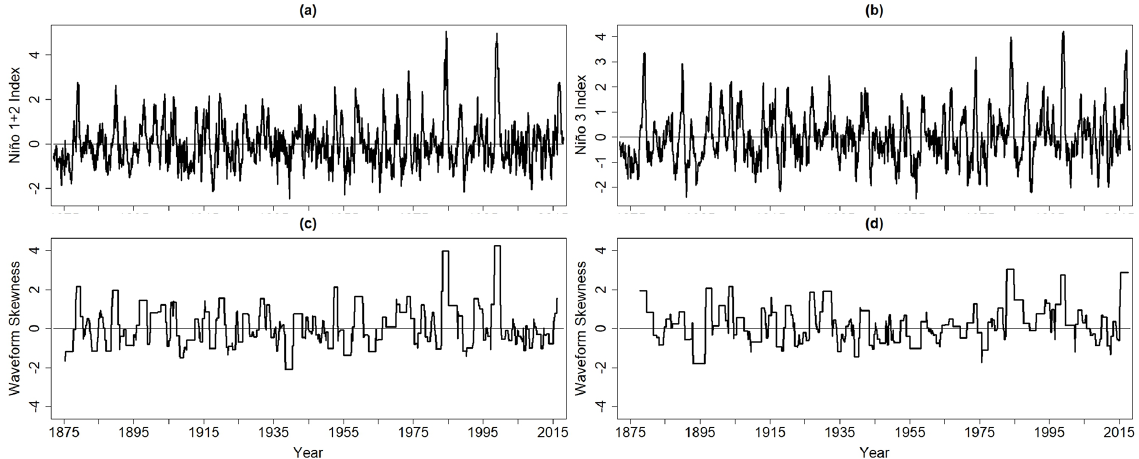
Figure 5. The standardized (a) Niño 1 + 2 and (b) Niño 3 indices together with the waveform skewness time series of the (c) Niño 1 + 2 and (d) Niño 3 indices.